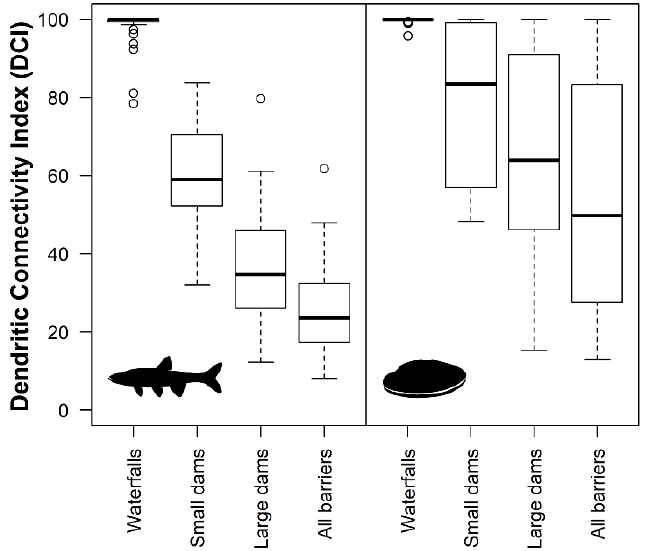
Figure 3. Boxplots of average Dendritic Connectivity Index (DCI) values among predicted habitats for fishes ( n = 27) and mussels ( n = 23) by barrier type using results from the biogeographic extent. DCI values range from 0 (complete habitat connectivity loss) to 100 (full habitat connectivity). Table 1. Mean, standard deviation, and range in statewide stream temperature and flow model estimates ( n = 68,123) for current, mid-century (2046–2065), and late century (2081–2100) time